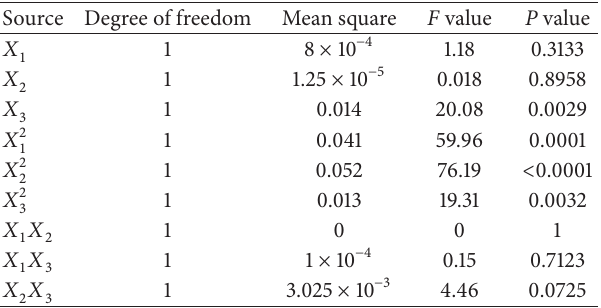
Table 4: Regression coefficients and significance test for quadratic